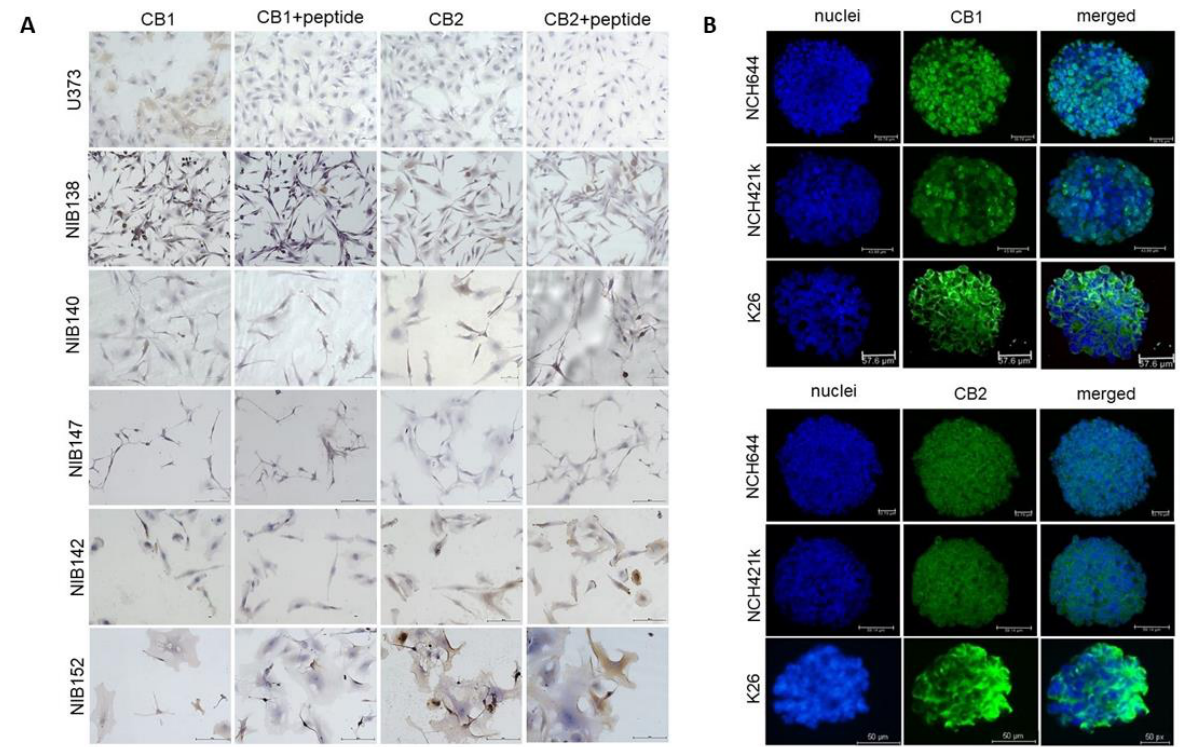
Figure 8. CB1 and CB2 receptors are differentially expressed in GB cells and GSCs. ( A ) Immunocytochemical staining of CB1 and CB2 receptors (brown) in GB cell lines established from patient tumour samples. Cell nuclei were counterstained with haematoxylin (blue), as described in detail in Materials and Methods (Sections 2.7 and 2.8). Scale bars: 50 µm. ( B ) Immunofluorescence staining of CB1 and CB2 receptors in the spheroids of two established GSCs and the patient-derived GSC cell line K26. Cell nuclei were counterstained with DAPI (blue), and the receptors CB1 and CB2 were stained with Alexa Fluor 488 (green). Scale bars: 50 µm.